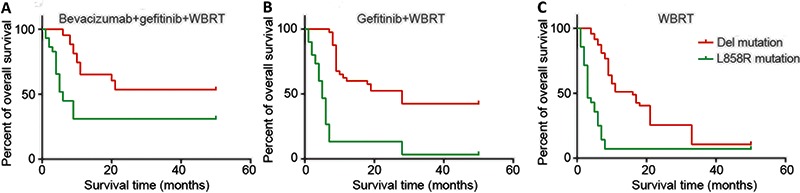
Kaplan-Meier estimation of overall survival rate in patients with brain metastases due to non-small-cell lung cancer with and without EFGR mutations treated with bevacizumab-gefitinib-WBRT, gefitinib-WBRT and WBRT. WBRT: whole brain radiotherapy.